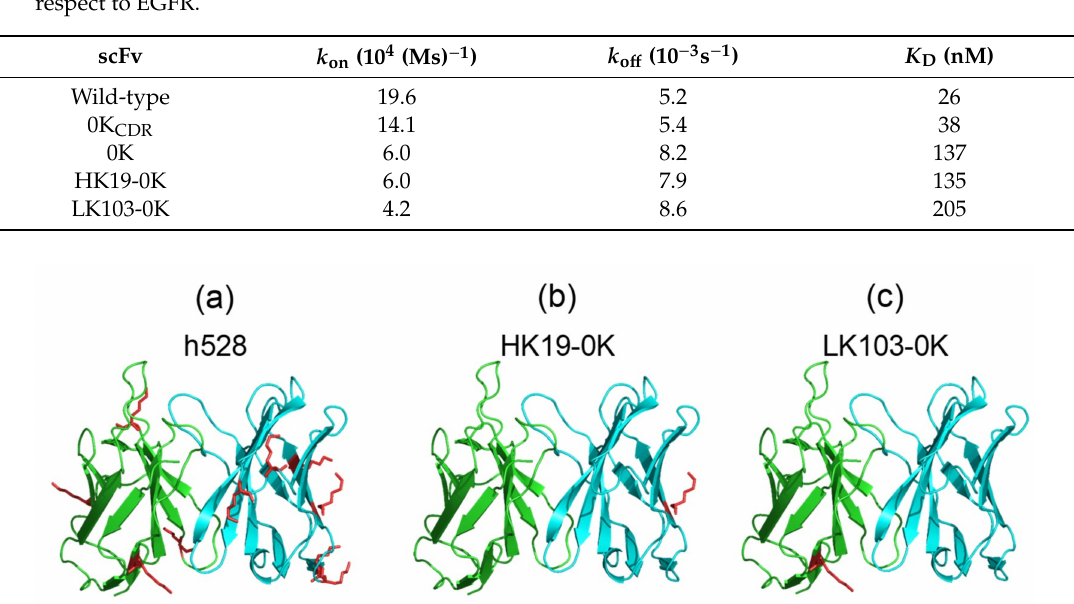
Table 2. Surface plasmon resonance measurements for the binding a ffi nity of h528 scFv variants with respect to EGFR.